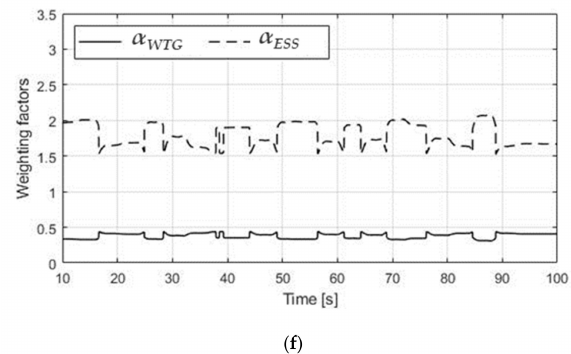
Figure 14. Simulation results for case 4: ( a ) system frequencies, ( b ) active powers of the WTG, ( c ) active powers of the ESS, ( d ) rotor speeds of the WTG, ( e ) SOCs of the ESS, and ( f ) weighting factors of the coordinated